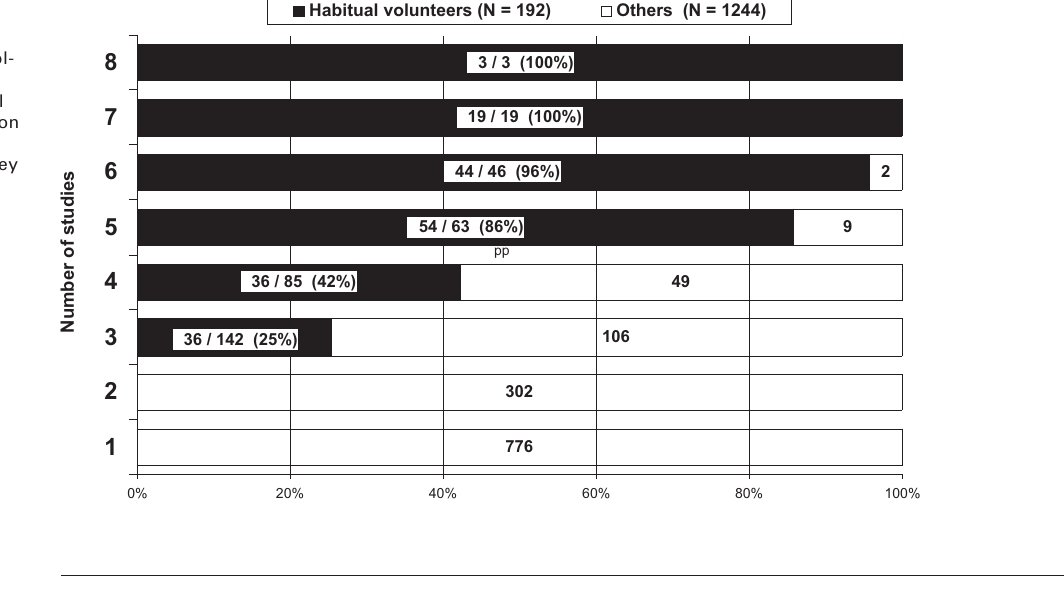
Study participation frequency of the vol- unteers and part taken from habitual volunteers in relation to the number of studies in which they have